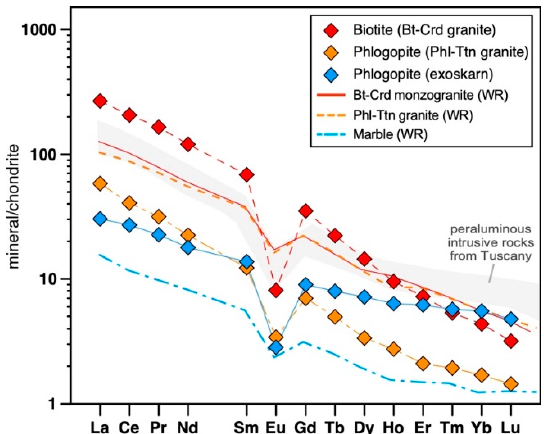
Figure 7. Chondrite-normalized REE pattern for biotite and phlogopite from the BM granite, and phlogopite from the exoskarn (bulk minerals separate). Whole-rock (WR) data from reference [1]. Chondrite normalization values after